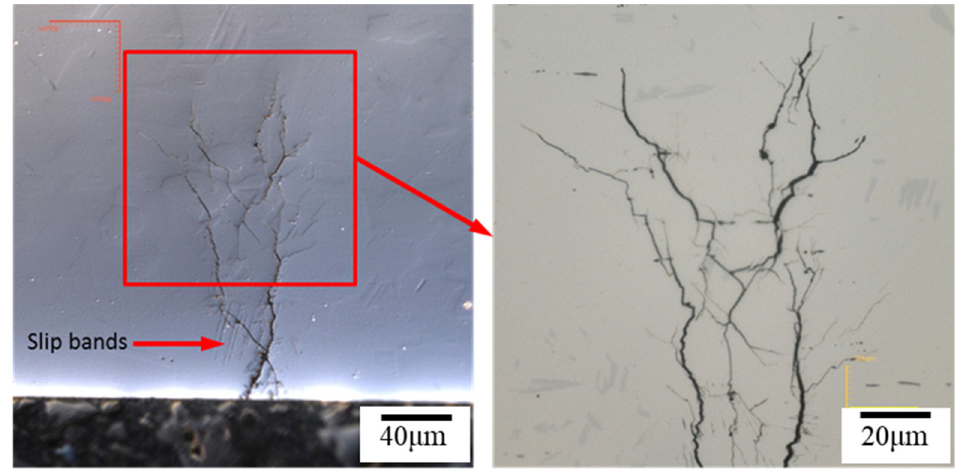
Figure 10. The cross ‐ section of the specimen with 0.1 g/m 2 of sea salt deposited on the surface reveals cracks after testing at 300 MPa tensile stress for 1500 h of testing at 45 °C and a relative humidity of 45%.